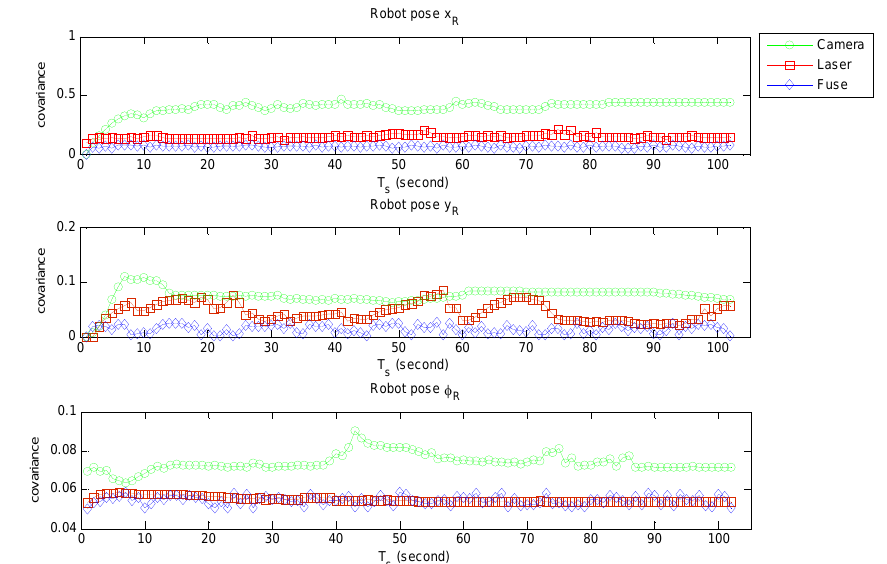
Figure 6. The estimated covariance of fused and individual robot pose. red line: estimated covariance in laser SLAM; green line: estimated covariance in monocular SLAM; blue lines: estimated covariance in MPEF-SLAM.